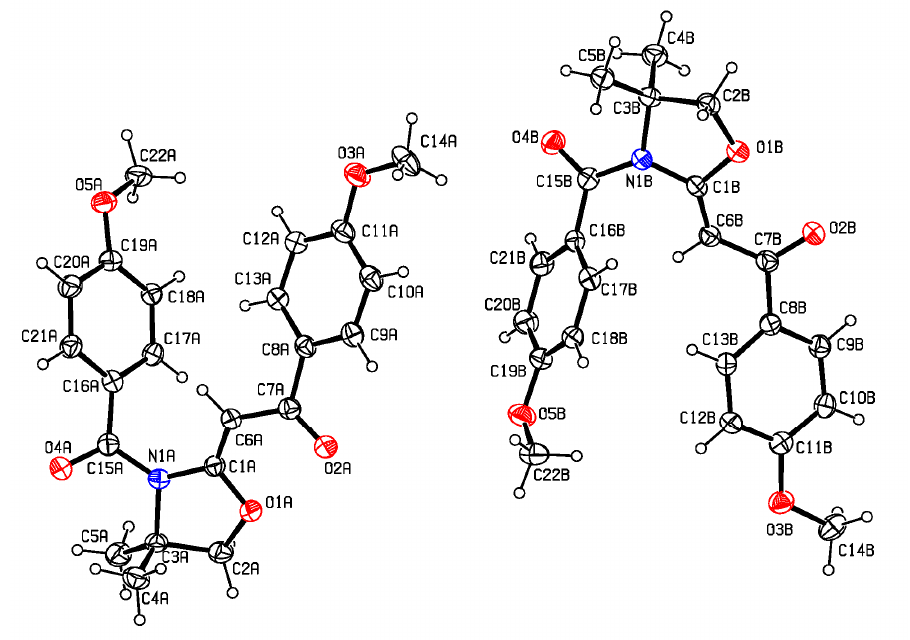
Figure 2. ORTEP representations (50% probability) of the two distinct molecules of 4 found in the unit cell: Molecule A (left) and Molecule B